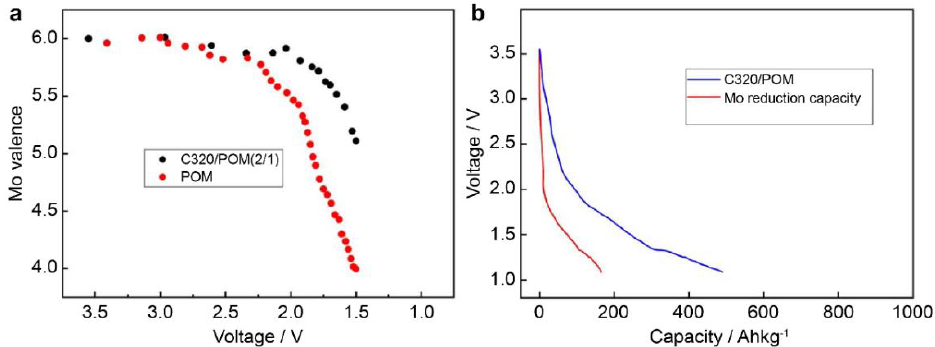
Figure 4. ( a ) Averaged Mo valence of the polyoxometalate (POM) molecule in the microcrystal POM-MCBs (red) and in the POM/C320-MCBs (black) as a function of the cell voltage. ( b ) Experimental discharge curve capacity (blue) and calculated curve (red) from the valence change in POM, for the POM/C320-MCB.